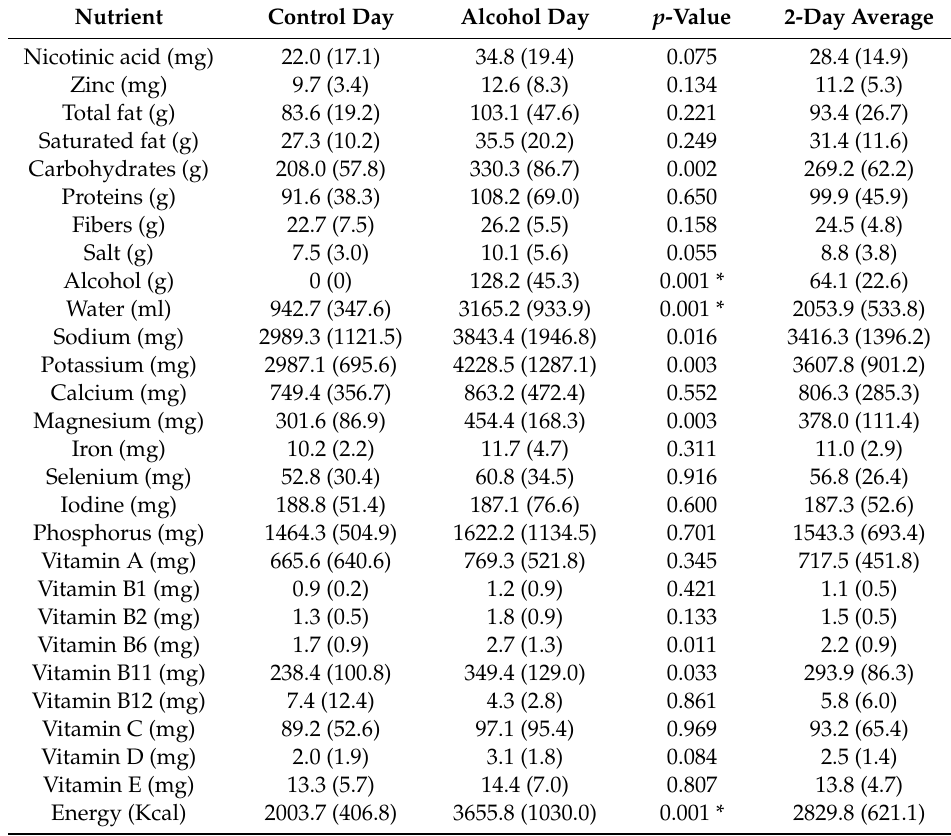
Table 1. Dietary nutrient